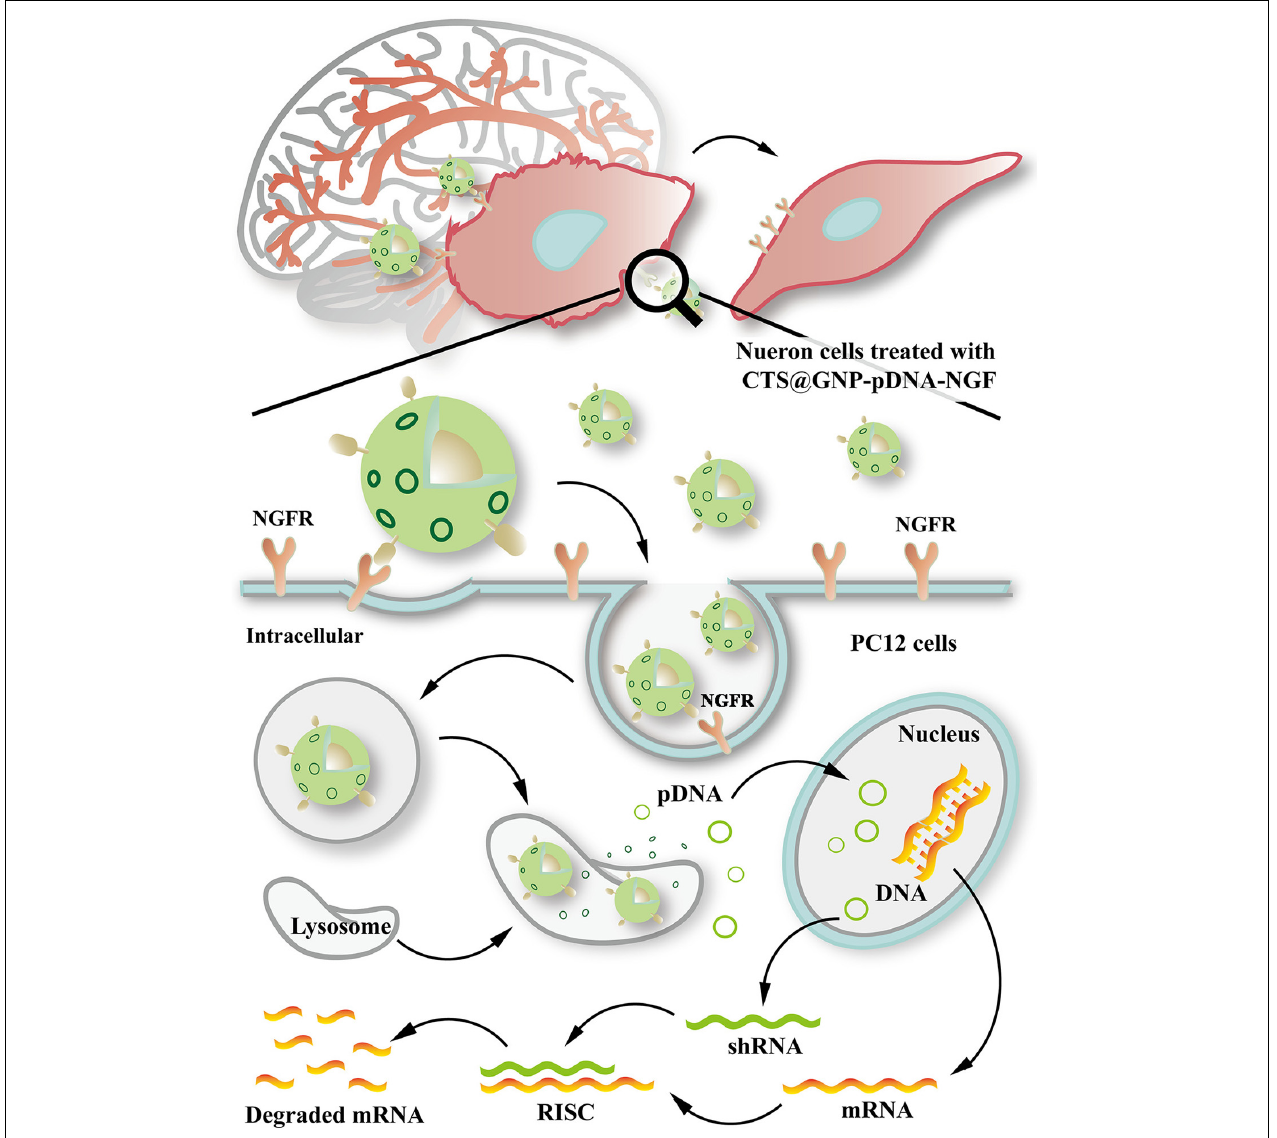
FIGURE 4 | Schematic diagram illustrating the internalization of gold nanoparticle composites by PC12 cells and the molecular cascade leading to formation of RNA-interfering silencing complex (RISC), which suppresses SNCA expression via degradation of mRNA. Reprinted from Hu et al. (2018), with permission from